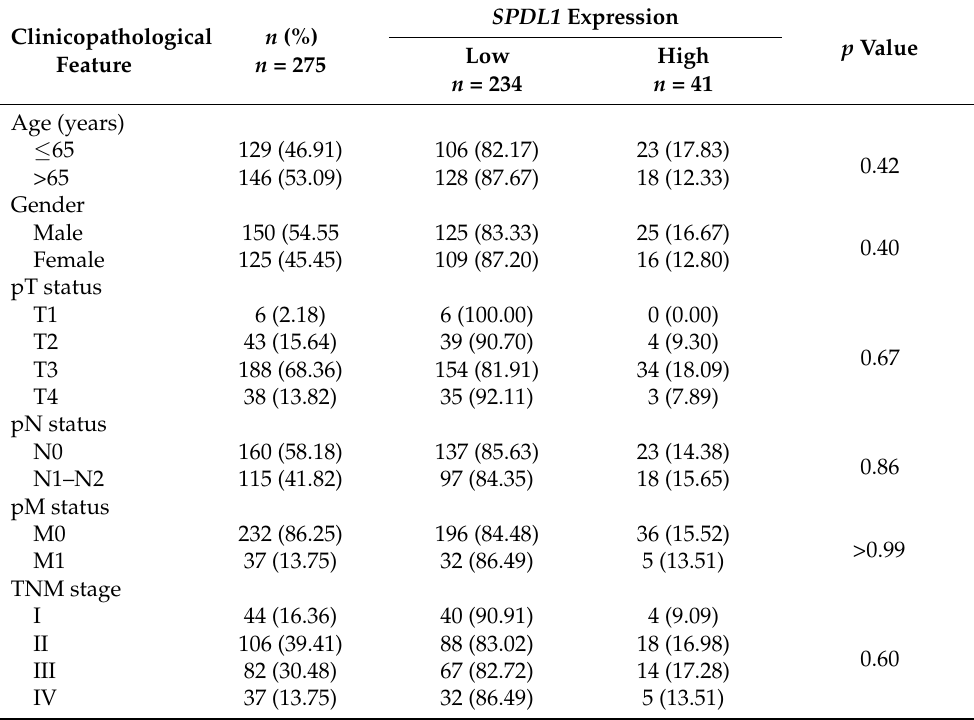
Table 3. Association of SPDL1 mRNA expression with clinicopathological parameters of colorectal cancer patients.